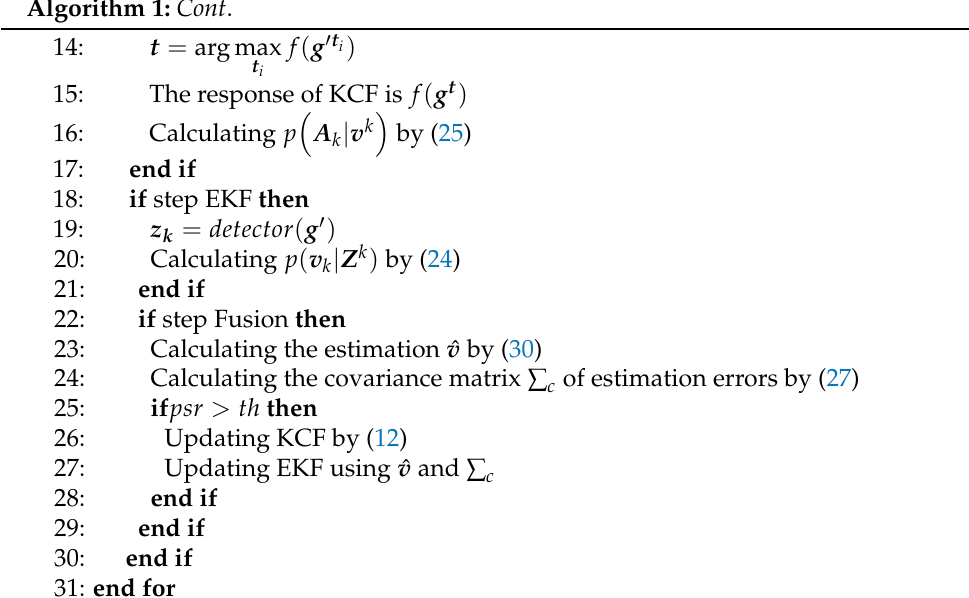
Calculating the covariance matrix ∑ c of estimation errors by (27)